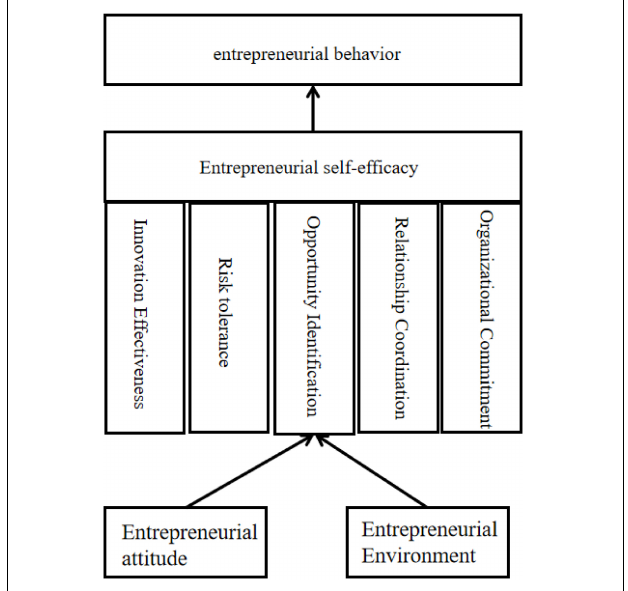
FIGURE 3 | Structural model of entrepreneurial